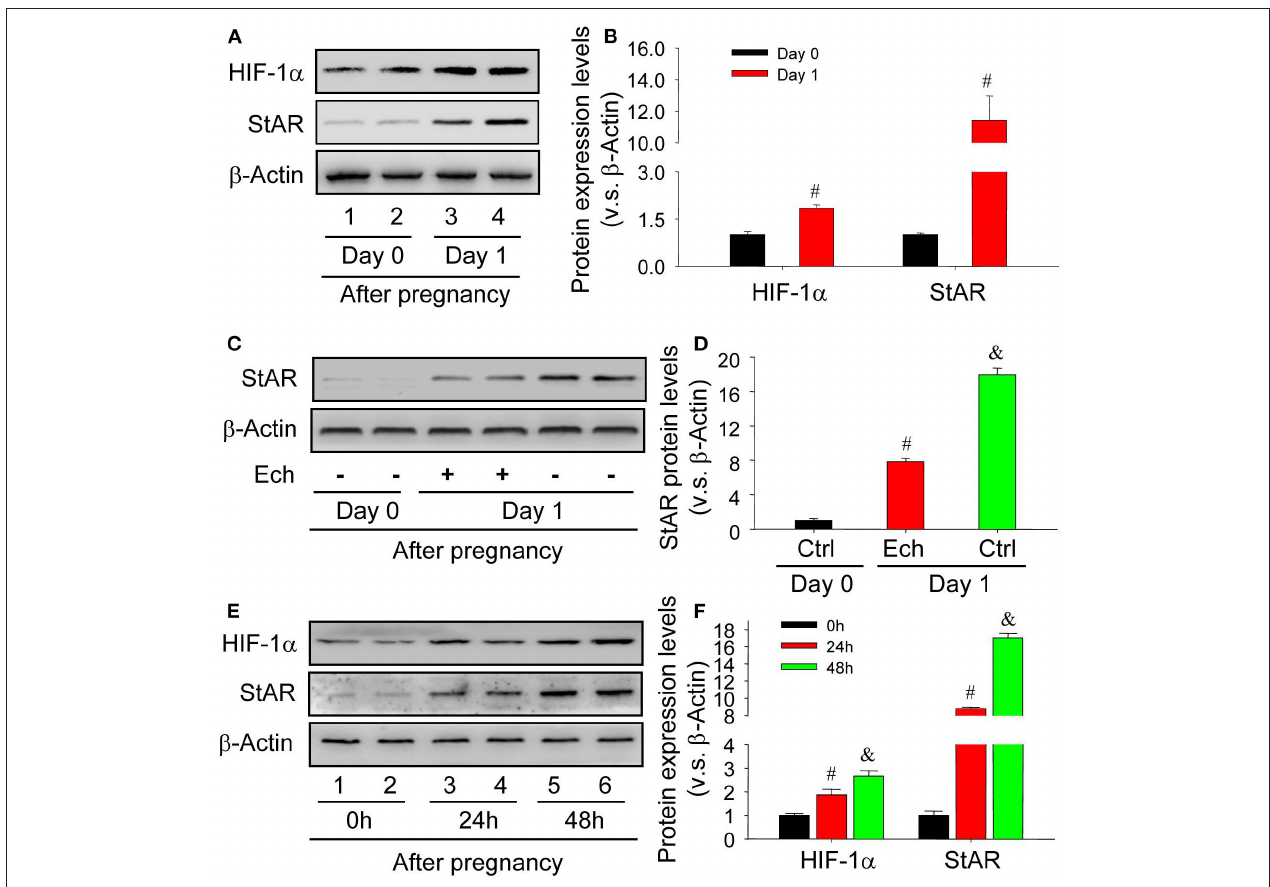
FIGURE 1 | HIF-1 α expression is concomitantly induced during the newly formation of corpus luteum. (A) Western analysis of HIF-1 α and StAR expressions on Day 0 and 1 after pregnancy. (B) Summarized intensities of HIF-1 α and StAR blotting normalized to the control (Day 0). (C) The expression changes of StAR in the presence or absence of echinomycin treatment on Day 1 after pregnancy. (D) Summarized intensities of StAR blotting normalized to the control (Day 0). (E) The expression changes of HIF-1 α and StAR in luteinizing granulosa cells wtih hCG and CoCl2 treatment. (F) Summarized intensities of StAR blots normalized to the control (0h). Each value represents the mean ± SE. One-way analysis of variance (ANOVA) was used to analyze the data, followed by a Tukey’s multiple range test. n = 6. # P < 0.05, vs. the group in black; & P < 0.05, vs. the group in red.